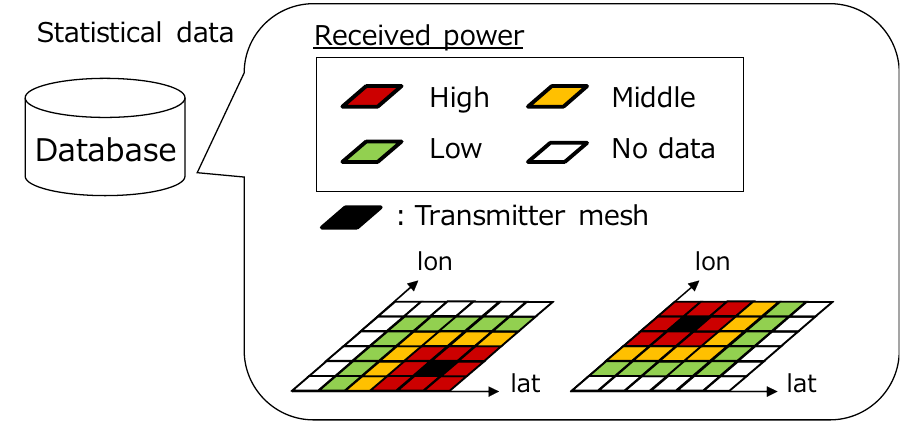
Figure 1. Concept of a radio environment database for wireless distributed